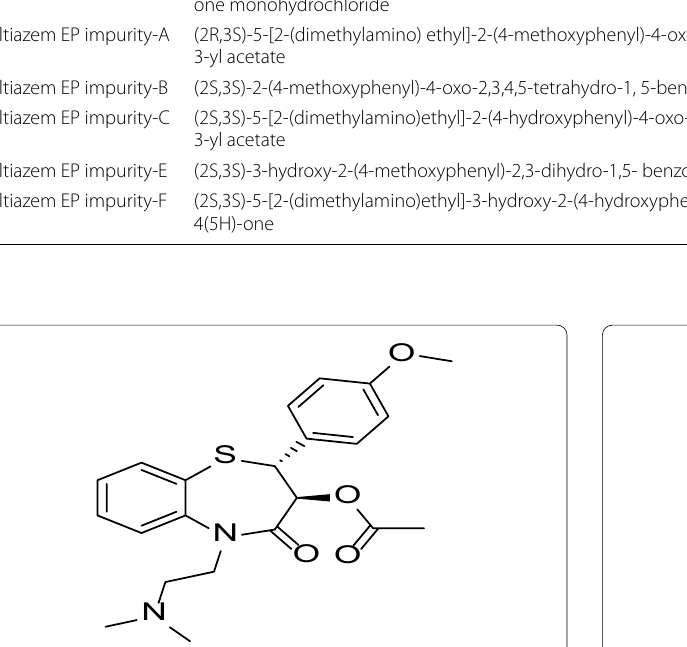
Fig. 2 Chemical structure of diltiazem EP impurity-A